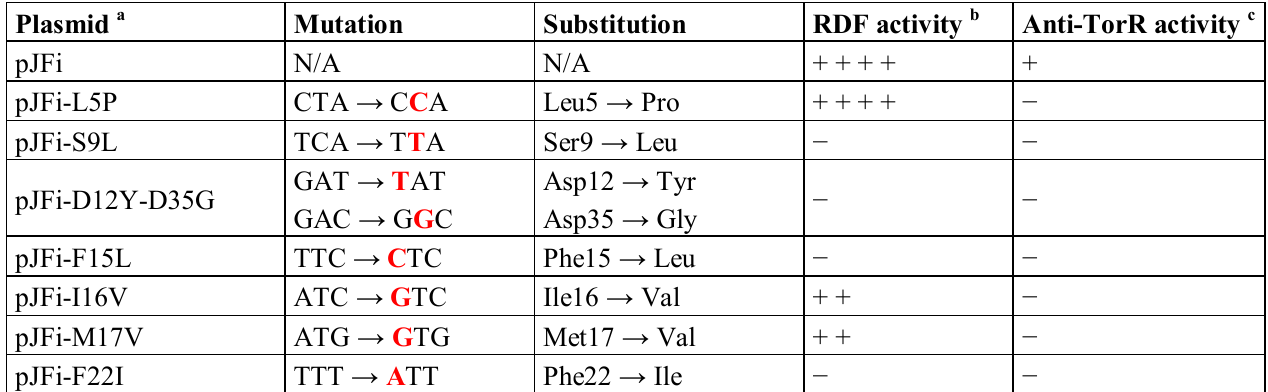
Table 1. Substitutions in TorI